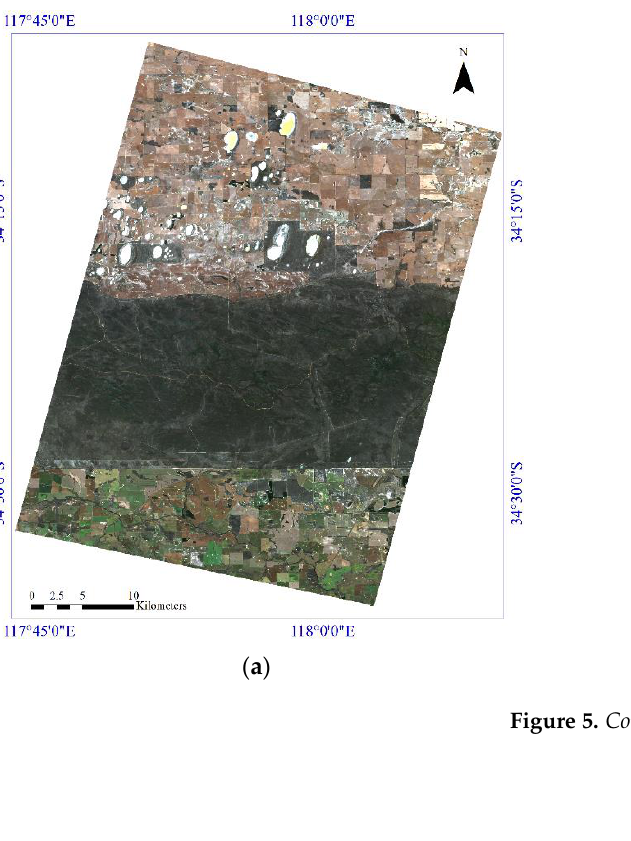
Figure 4. The dataset used for the burned area mapping for the first study area. ( a ) Pre-event Sentinel-2 imagery. ( b ) Post- event Sentinel-2 dataset. ( c ) Post-event PRISMA hyperspectral imagery. ( d ) Ground truth.